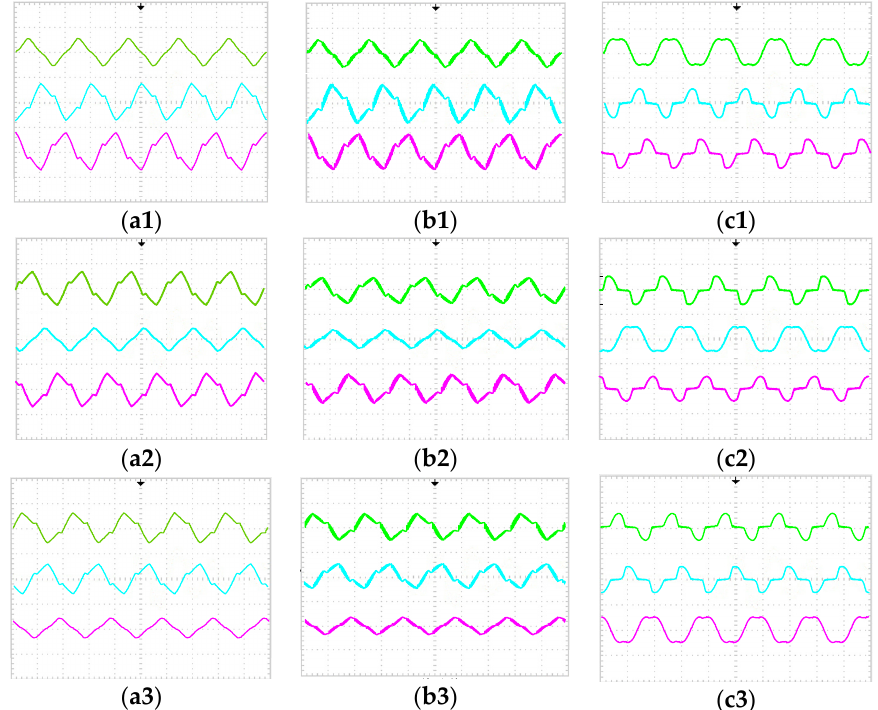
Figure 9. The experimental results of the non-reconfigurable inverter ( a1 ) output voltages under faulty phase a; ( a2 ) output voltages under faulty phase b; ( a3 ) output voltages under faulty phase c; ( b1 ) currents under faulty phase a; ( b2 ) currents under faulty phase b; ( b3 ) currents under faulty phase c; ( c1 ) voltage deviations under faulty phase a; ( c2 ) voltage deviations under faulty phase b; ( c3 ) voltage deviations under faulty phase c.